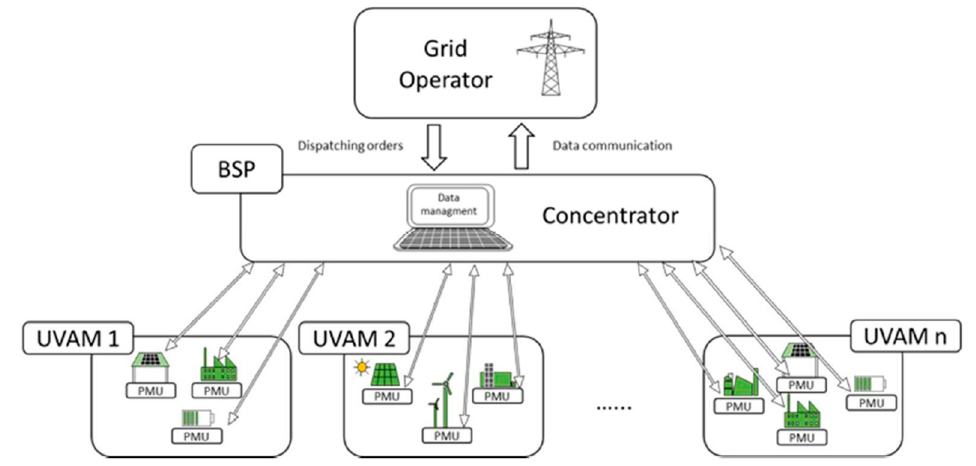
Figure 2. Operation diagram of a UVAM .